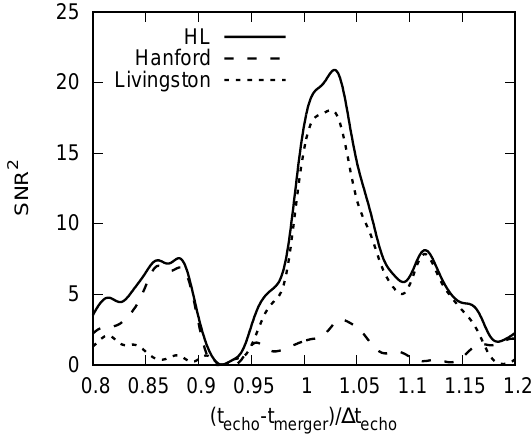
Figure 21. SNR 2 with respect to T = ( t echo − t merger ) / ∆ t echo . Solid, dashed, and dotted lines correspond to ρ 2 for combined (Hanford and Livingston), Hanford, and Livingston, respectively, for the best fit parameter case for GW150914.